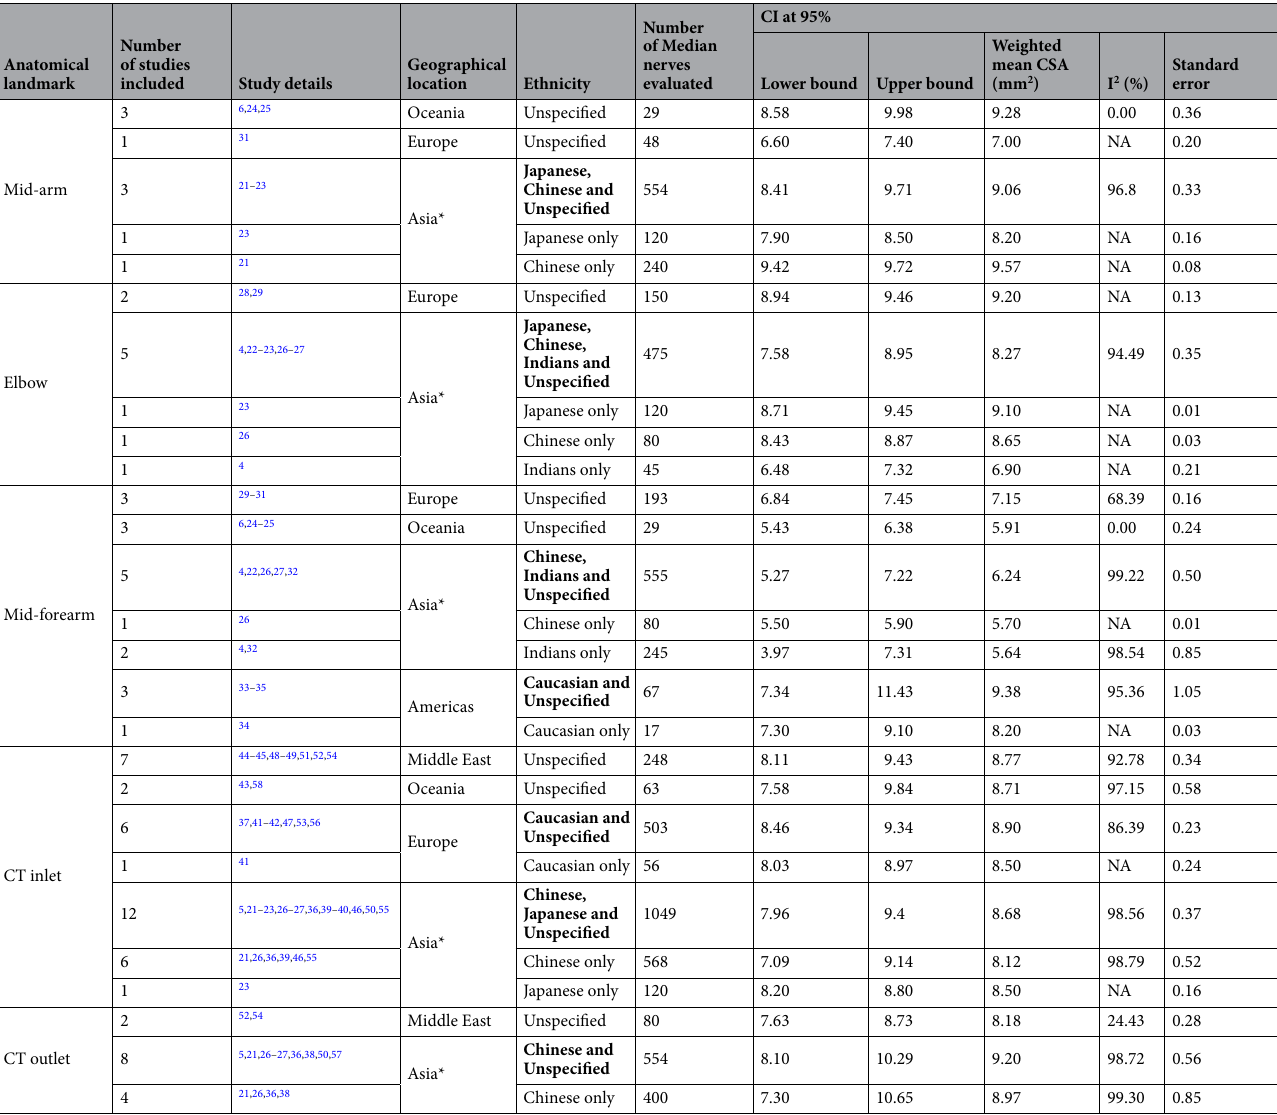
Table 4. Subgroup analysis (of included studies, n = 41) of median nerve CSA based on geographical location and ethnicity (of included studies, n = 12) at different anatomical landmarks. CSA = cross sectional area. CI = confidence intervals. NA indicates the inclusion of only one study for the analysis, hence heterogenicity (I 2 ) cannot be calculated. Unspecified indicates study that has not mentioned sub-population group and hence meta-analysis was performed based on geographical location.*Indicates Asia excluding Middle Eastern